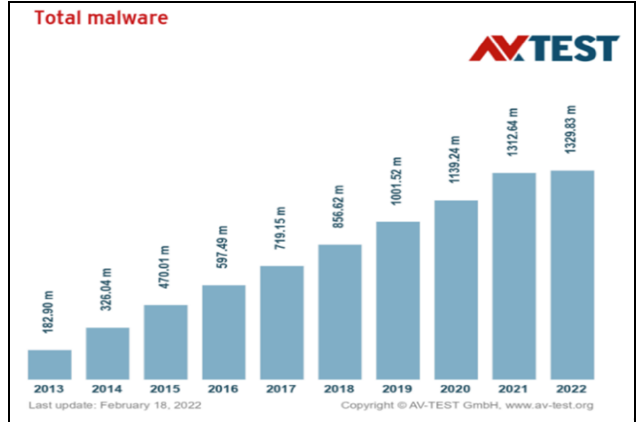
Figure 2. Every day, the AV-TEST Institute registers over 450,000 new malicious programs (malware) and potentially unwanted applications (PUA). Of total threats examined, 95.30% were malware and 4.70% were PUAs (source: https://www.av-test.org, accessed on 27 June 2022) .